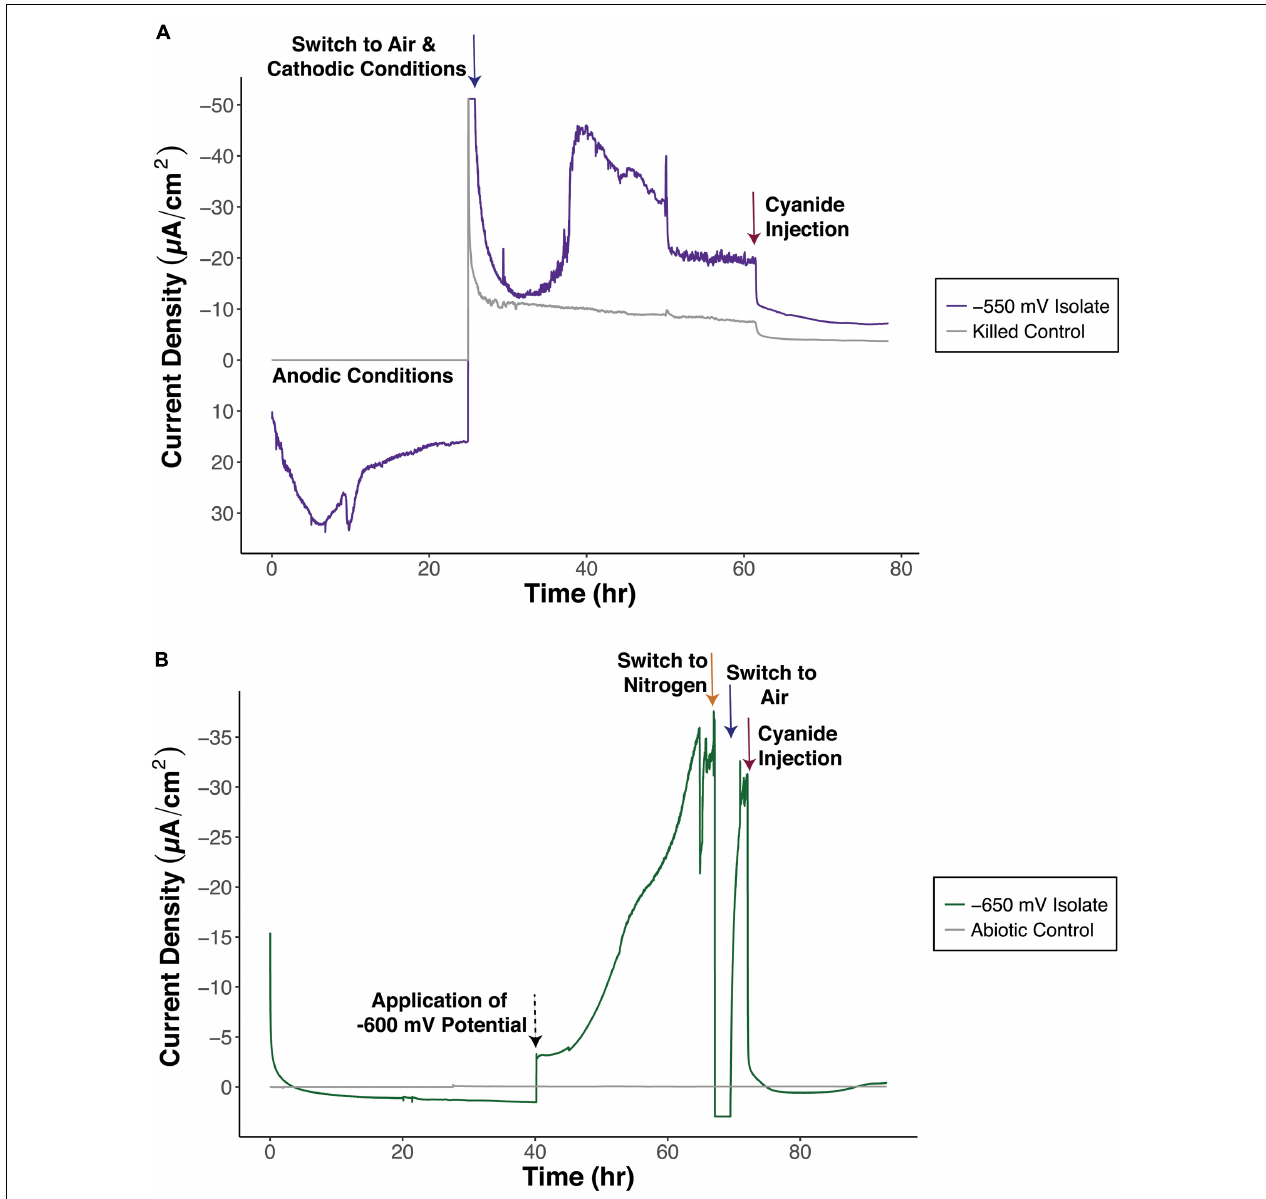
FIGURE 5 | Representative chronoamperometry plots to test for electrochemical activity of isolates, (A) –550 mV Isolate 1, Vibrio sp. and (B) –650 mV Isolate 1, Marinobacter sp. –550 mV Isolate 1 was initially exposed to anodic conditions before switching to cathodic conditions. The applied potential for the –650 mV Isolate 1 was changed from –400 to –600 mV (vs. Ag/AgCl) at the 40 h time point. Arrows indicate switches in conditions. Blue arrows signify air and cathodic conditions, orange arrow indicates purging with nitrogen, red arrows indicate cyanide injection, and black dashed arrow indicates change in applied redox potential.